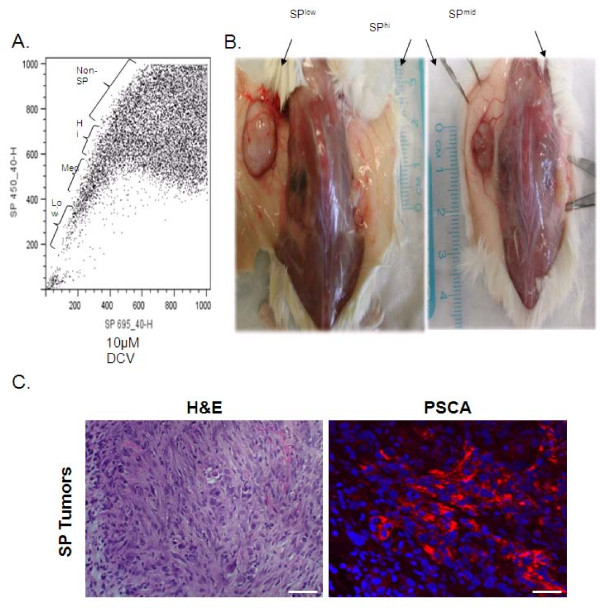
Analysis of SP and non-SP used for cell isolation and for animal experiments. A) RC-58T/hTERT/SA#4-D cells were subjected to Hoechst 33342 dye and separated into SPlow, SPmid, and SPhi fractions B). Individual SP fractions were then injected subcutaneously and assayed for tumorigenicity, after 100 days in NOD-SCID mice. Tumors were subsequently measured for tumor volume as shown by schematic representing xenograft tumors. D). Formalin-fixed, paraffin-embedded tissues were obtained from SP generated xenograft tumors. Individual tissues sections were stained with H&E or human specific primary PSCA antibody, and Alexa Fluor-594 secondary (red) and Dapi (blue) nuclear stain. Scale bar indicates 40 μM.